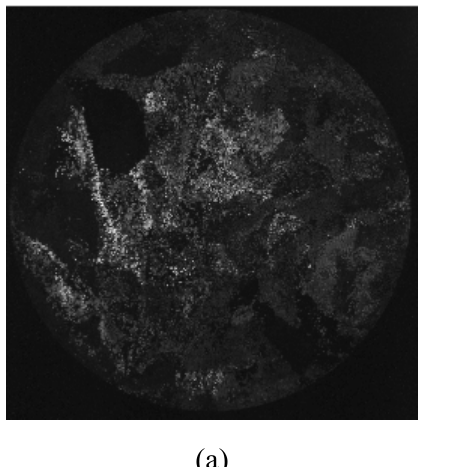
Figure 3. Reconstruction result using a process beginning with a calibration